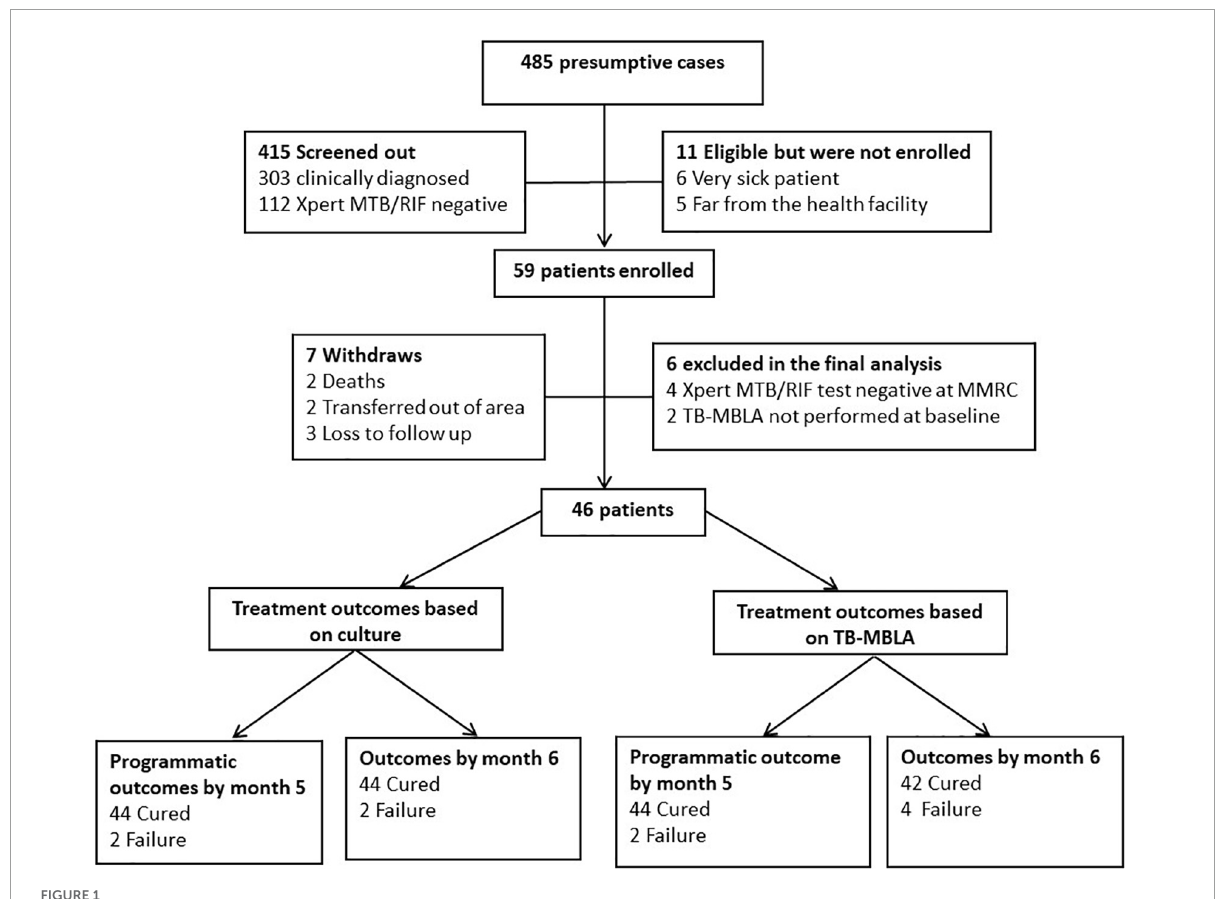
FIGURE1 Screening workflow, enrollment, follow-up, and final outcomes. Three hundred and three patients were screened out because they were bacteriological test negative at diagnosis and were treated clinically. Of the 59 enrolled patients, seven patients withdrew from the study (two died, three transferred out of the area, and three were lost to follow-up). Six patients were excluded from the final analysis (four due to inconsistent Xpert MTB/RIF results at the health facility and confirmatory Xpert MTB/RIF test at the NIMR-MMRC testing laboratory and two patients had low sputum volume for TB-MBLA at baseline). Three patients were lost to follow-up and two patients who were HIV positive